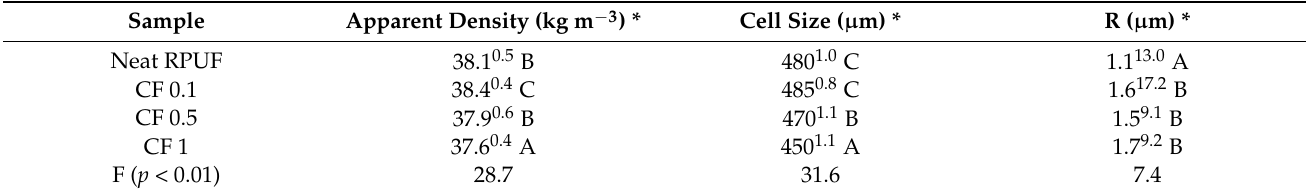
Table 2. Morphological characteristics for the studied RPUF composites.